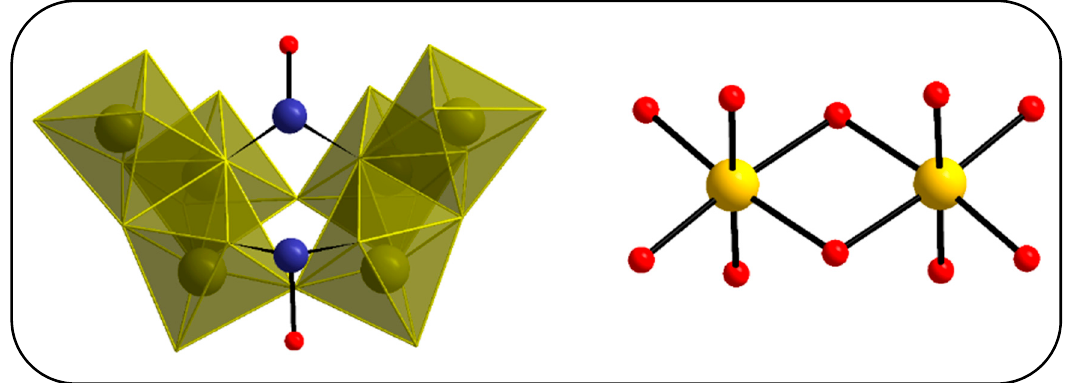
Figure 2. Combined polyhedral / ball-and-stick representation: Left {(As III W 6 O 23 )(As III O 3 H)}. Right Fe III 2 core. Color code: WO 6 octahedra olive green, As blue, Fe yellow, O red.